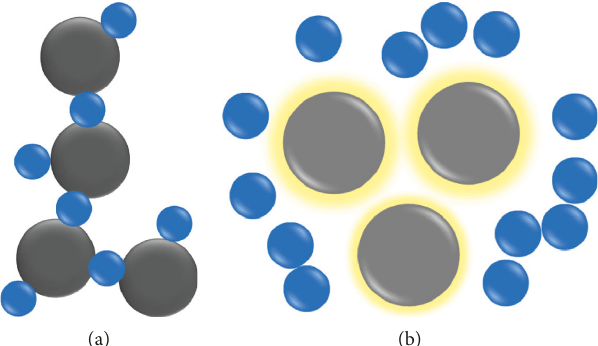
Figure 1: The schematics of the colloidal probes of microrheology (grey spheres) aggregate through (a) bridging, and (b) depletion of the microgels (blue